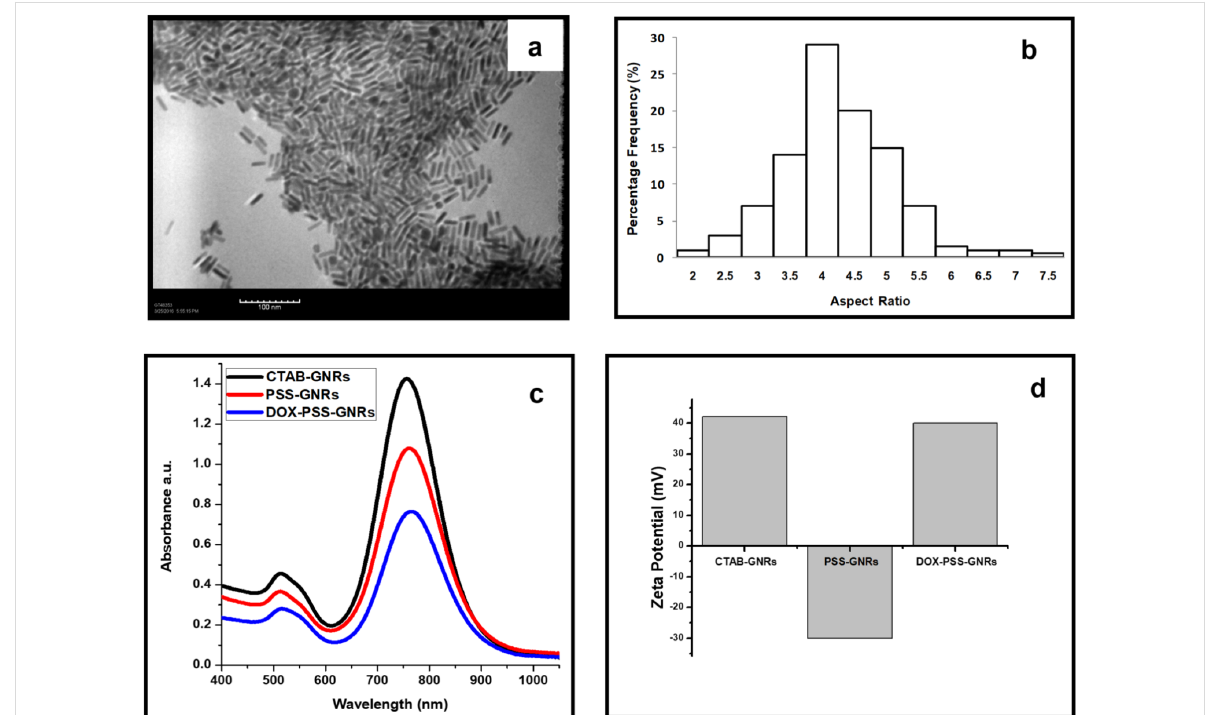
Figure 1: (a) TEM image of monodispersed GNRs. (b) Histogram showing the aspect ratio of GNRs. (c) UV–vis absorption spectrum of bare GNRs, PSS-coated GNRs and DOX-loaded PSS-GNRs. (d) Zeta potential of CTAB-coated GNRs, PSS-GNRs and